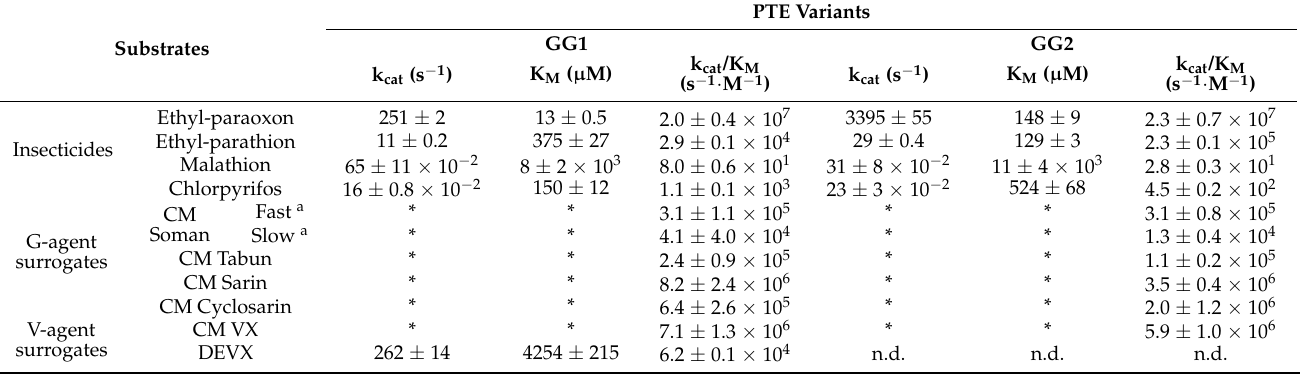
Table 1. Activity of PTE variants against insecticides as well as G- and V-agent surrogates.